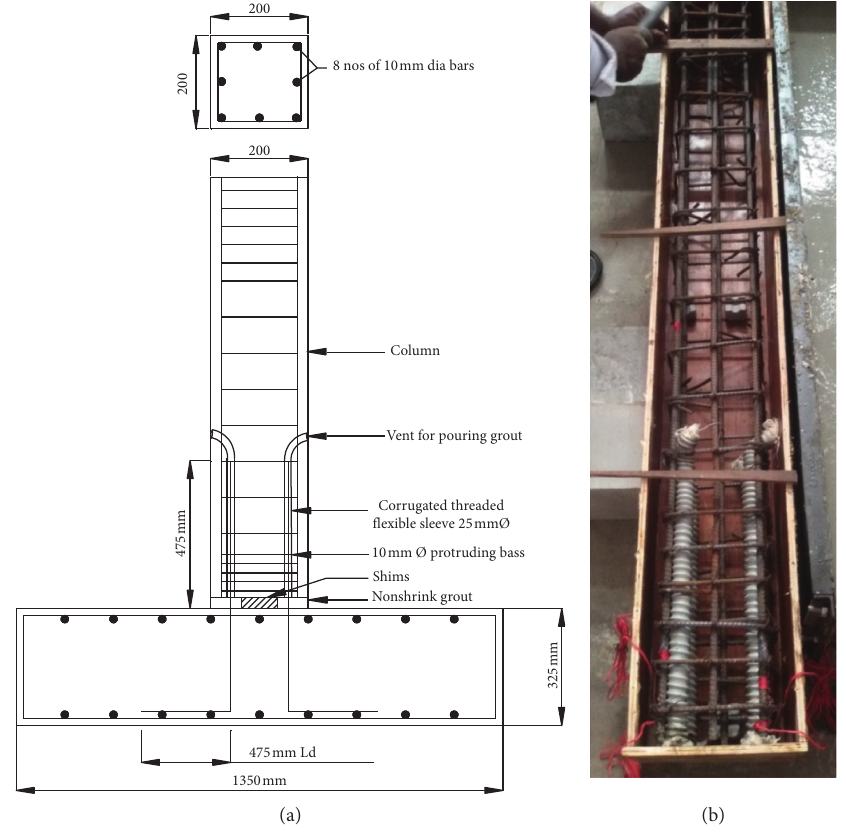
Figure 9: Reinforcement details of grouted sleeve specimen (GS).